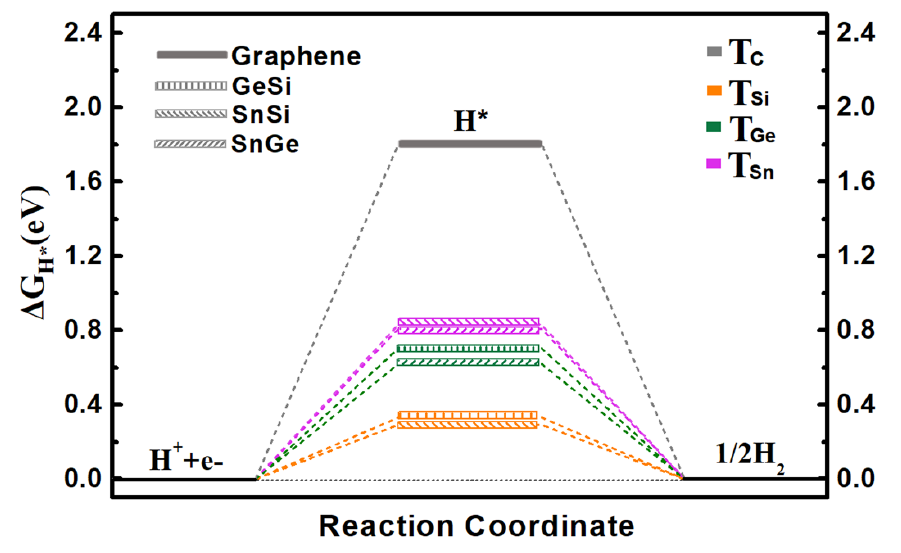
Figure 2. The calculated free-energy diagram of HER on the pristine graphene, GeSi, SnSi, and SnGe structures at equilibrium potential for different adsorption sites.